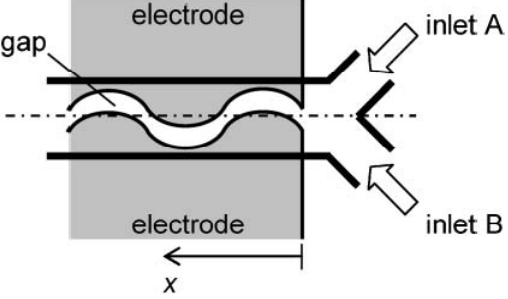
Figure 23. Schematic of “Y” shape microchannel with a pair of meandering electrodes for ac electroosmosis (from Sasaki et al.